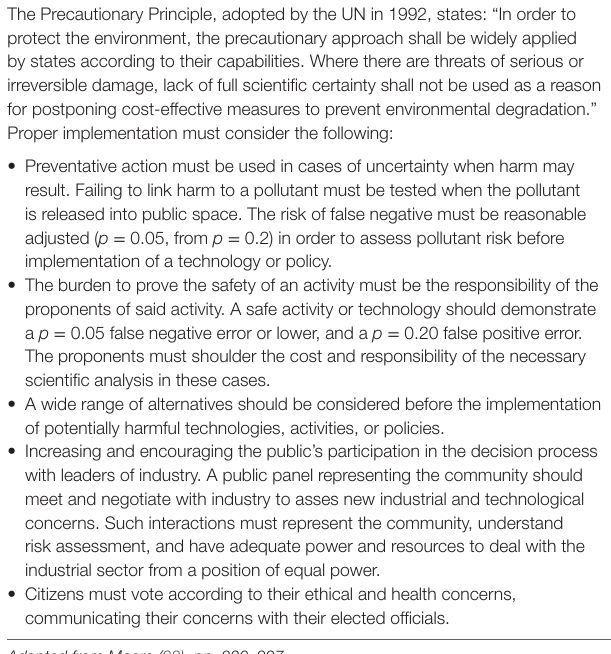
tABLe 2 | Recommendations for effective application of the precautionary